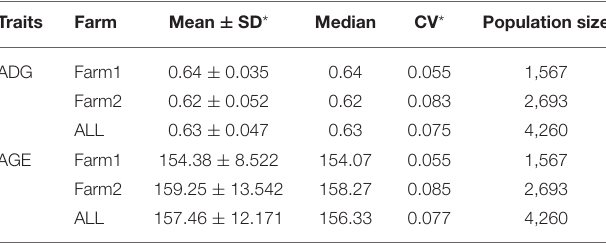
TABLE 1 | Summary statistics of ADG and AGE that adjusted to 100kg for all breeds. Traits